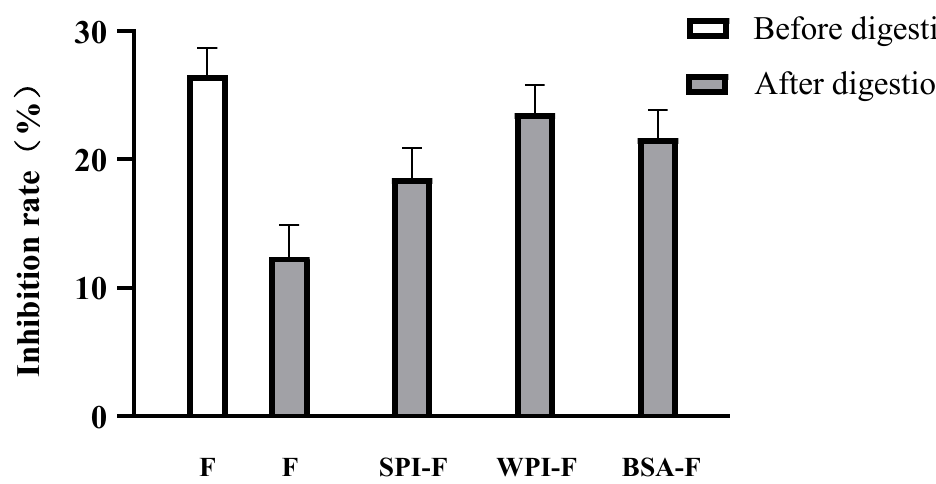
Figure 3. In vitro α -glucosidase inhibition rates of flavonoids with and without combied with protein before or after being digested with the simulated gastrointestinal conditions.